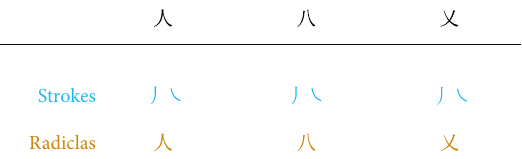
Figure 1: Strokes and radicals of “ 人 ”, “ 八 ”, and “ 乂